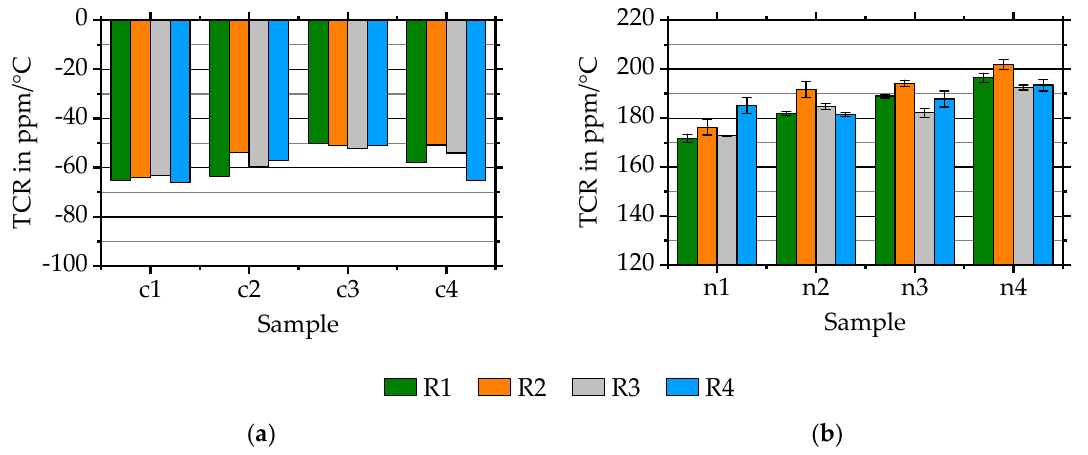
Figure 4. TCR values of ( a ) directly deposited Constantan samples and ( b ) of NiCr 80/20 samples.